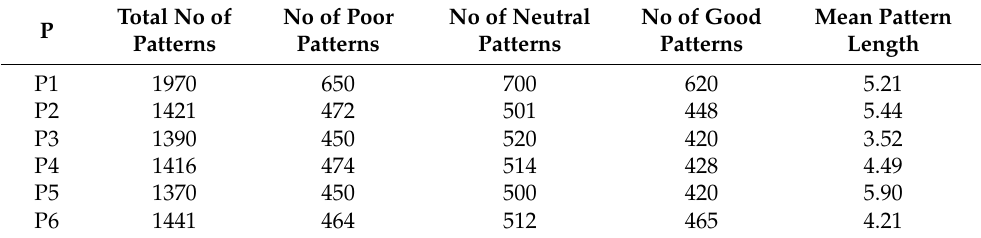
Table 5. Summaries for the classified patterns for all participants ( n =